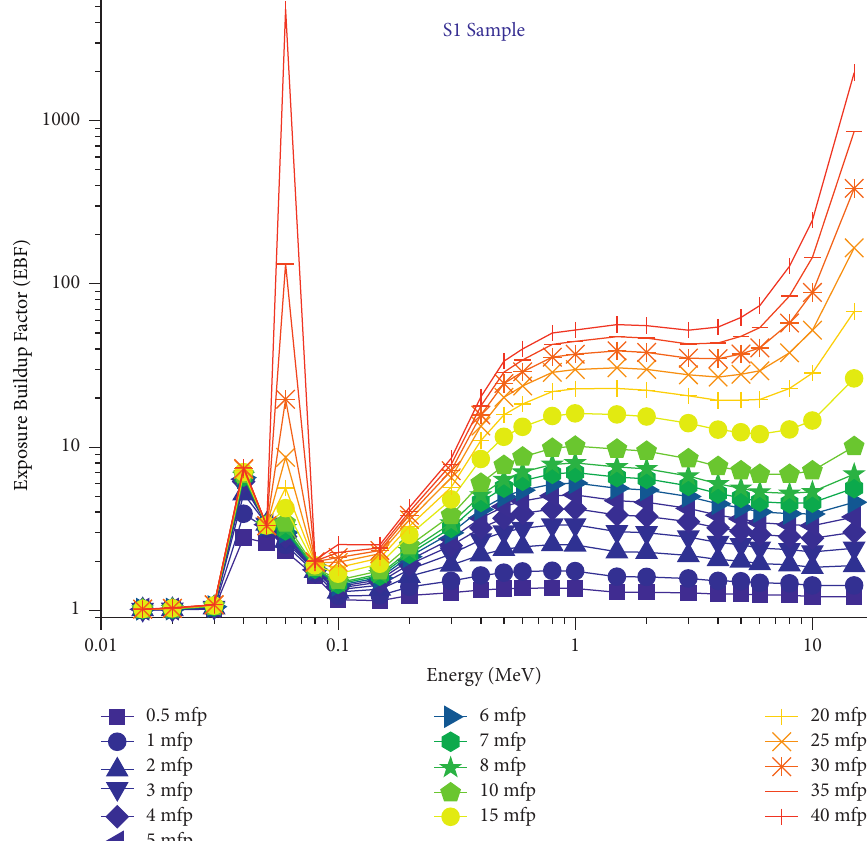
Figure 10: Demonstrates the relationship between the energy and EBF of the S1